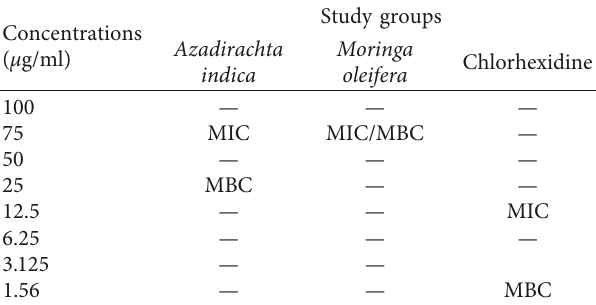
Table 2: Bacteriostatic (MIC) and bactericidal (MBC) of 2% chlorhexidine and methanolic extracts of Moringa oleifera and Azadirachta indica against Enterococcus faecalis